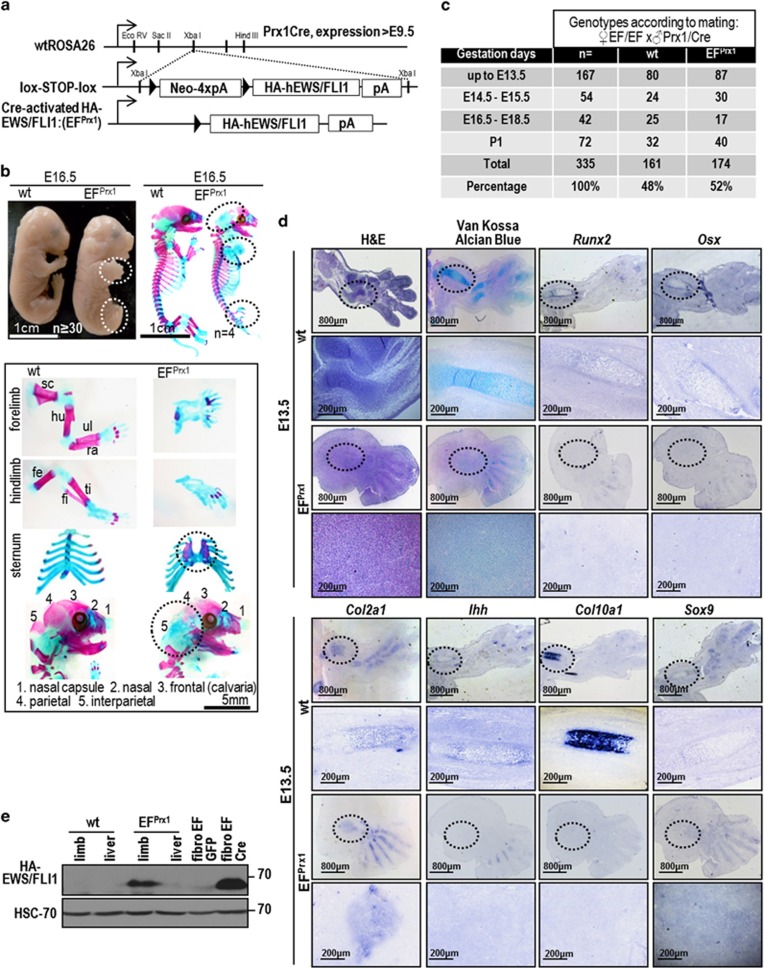
EF expression blocks bone differentiation causing skeletal defects in EFPrx1 mice. (a) Scheme of the ROSA26-lox-STOP-lox-HA-hEWS/FLI1 transgenic mouse. (b) Representative picture of wt and EFPrx1 E16.5 embryo displays malformed limbs as indicated by black dashed circle. Skeletal preparations and analysis with Alcian Blue/Alizarin Red staining of E16.5 wt and EFPrx1. sc, scapula; hu, humerus; ra, radius; ul, ulna; ti, tibia; fi, fibula; fe, femur. (c) The list summarizes number of embryos (total, wt, EFPrx1) at different gestation days, and cumulative percentages/normal Mendelian ratio with indicated embryo numbers. (d) Histology analysis of E13.5 limbs stained by H&E or Van Kossa/Alcian Blue, which stains cartilage in blue and bone elements in red, indicated that there was no significant hypertrophic region present in EFPrx1 embryos in contrast to wt limbs. RNA in situ hybridization of E13.5 limbs confirmed an arrest in chondrocyte and osteoblast differentiation. For all embryos consecutive sections were performed. At least three different independent embryos for every single staining and for each time point were analyzed. Black circles indicate the magnified region showing in the lower row. (e) Detection of EF expression at the protein level at E16.5 using HA-tag antibody displayed significant transgenic protein product in limbs from EF mice. HSC-70 was used as a loading control. Fibro GFP or CRE: fibroblasts isolated from EF mice lentiviral-transduced with a construct containing GFP or the CRE recombinase was used as controls. Numbers of analyzed embryo/mice are indicated to corresponding images